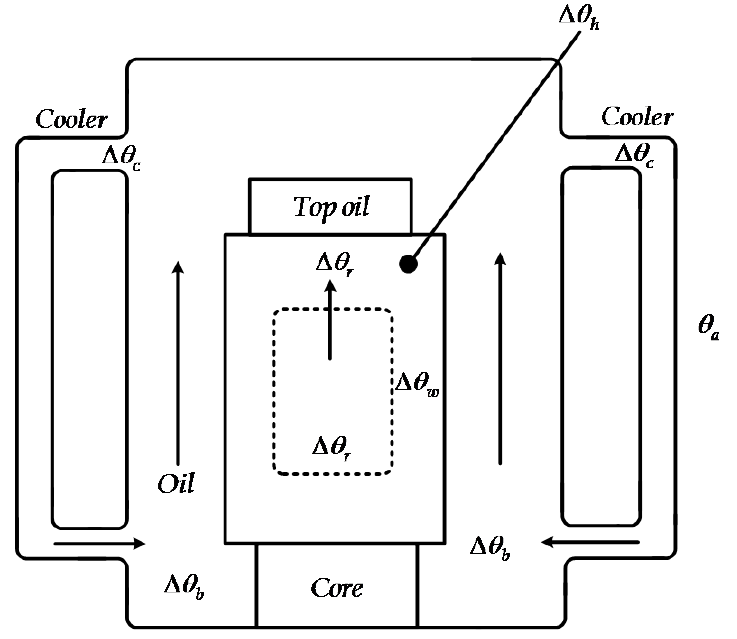
Figure 2. Basic thermal diagram of oil transformers.